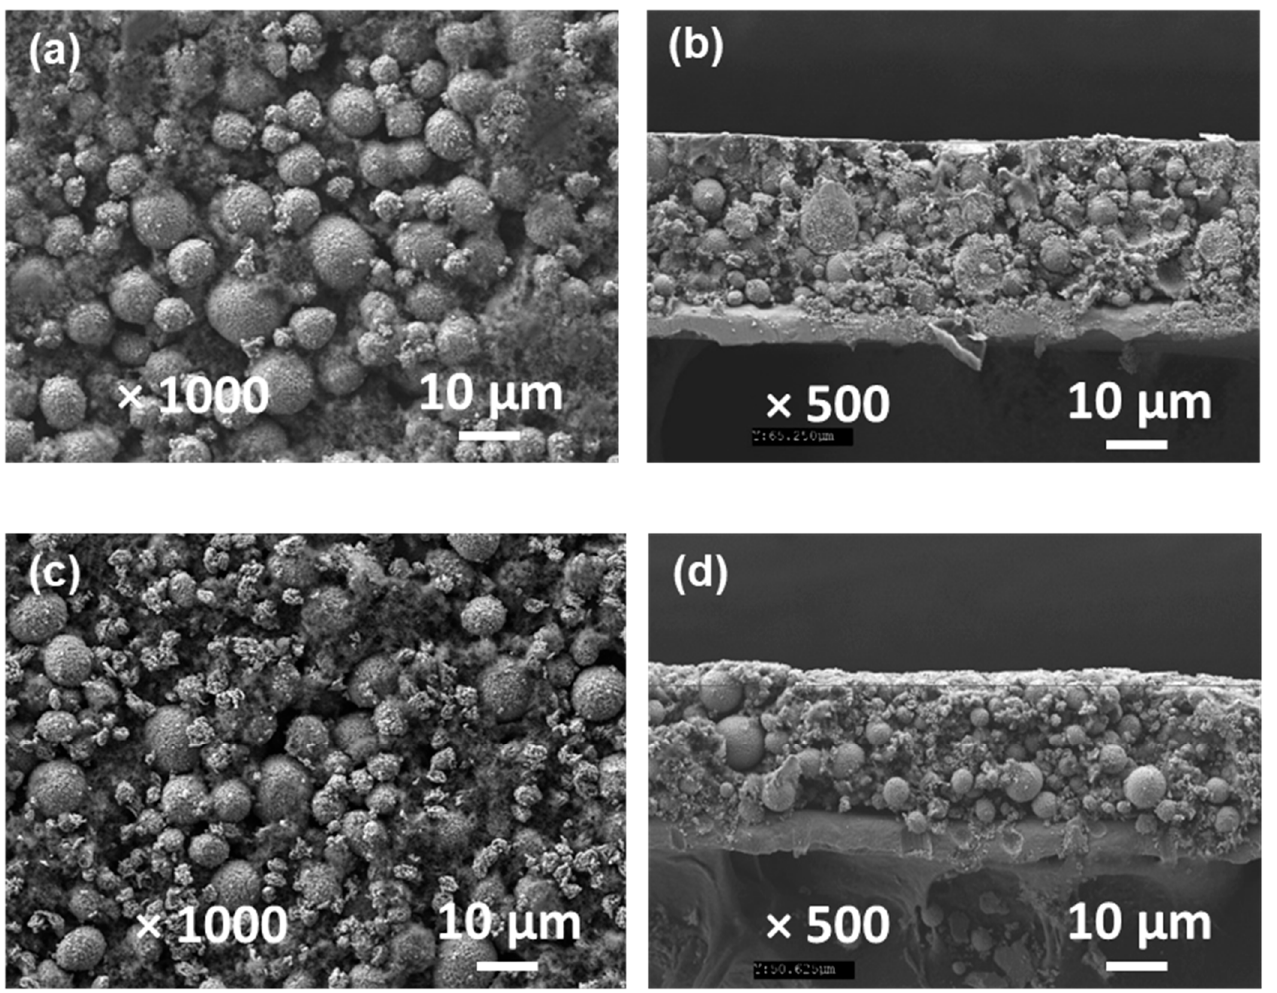
Figure 6. SEM micrographs of normal and cross-section mode for ( a , b ) L100% and ( c , d ) L80% + S20% electrodes.